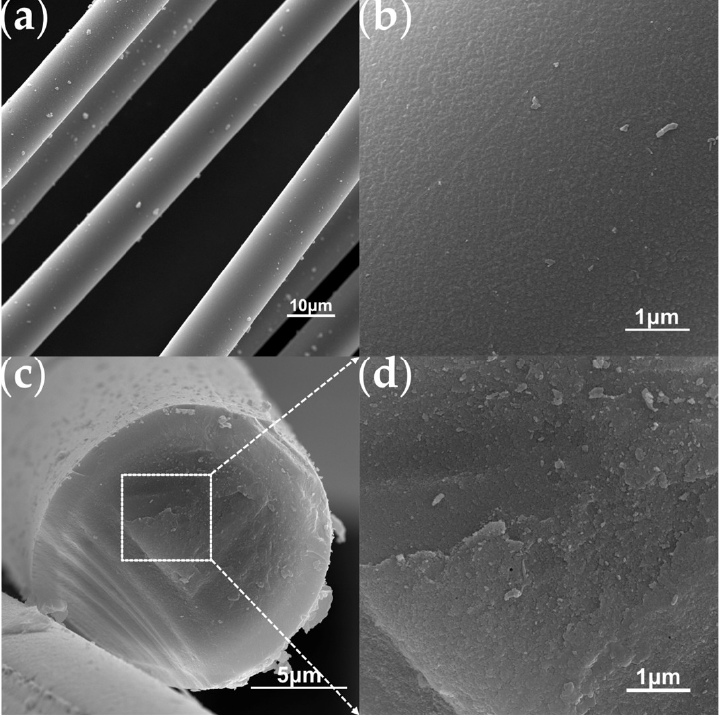
Figure 4. SEM images of the Si–C–O–Ti–B fibers. ( a ) Surface of Si–C–O–Ti–B fibers. ( b ) Enlarged view of the surface morphology. ( c ) Cross–section of Si–C–O–Ti–B fibers. ( d ) Enlarged view of the cross section morphology.